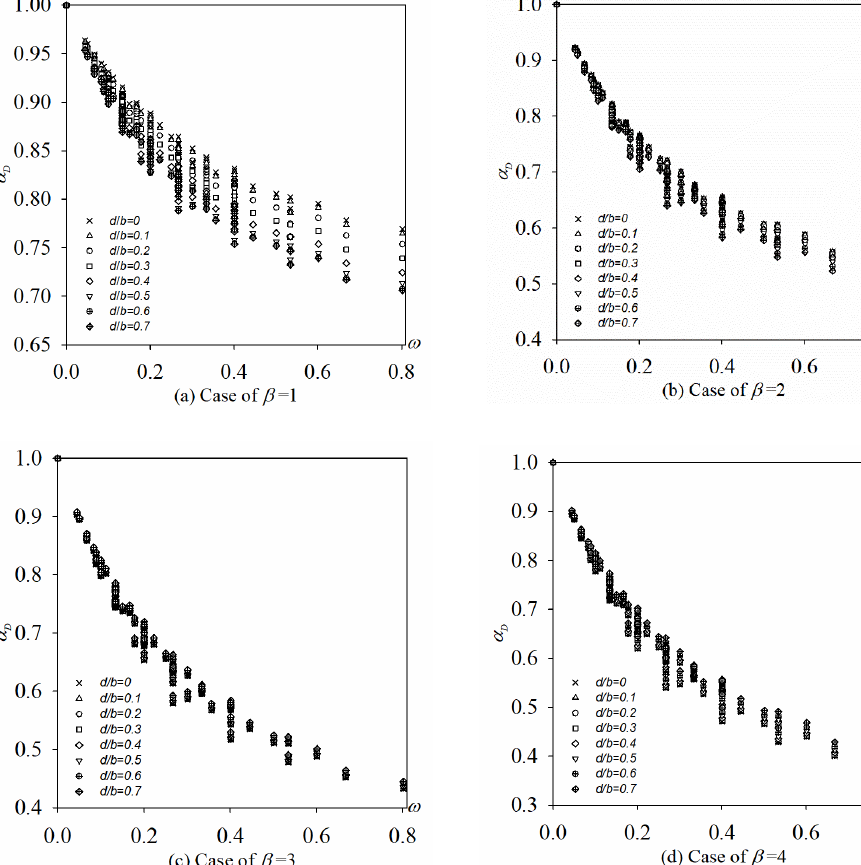
Figure 15. α D vs. ω for perforated rectangular plate ( β = 1, 2, 3, 4) with the BCs of 3S1F.